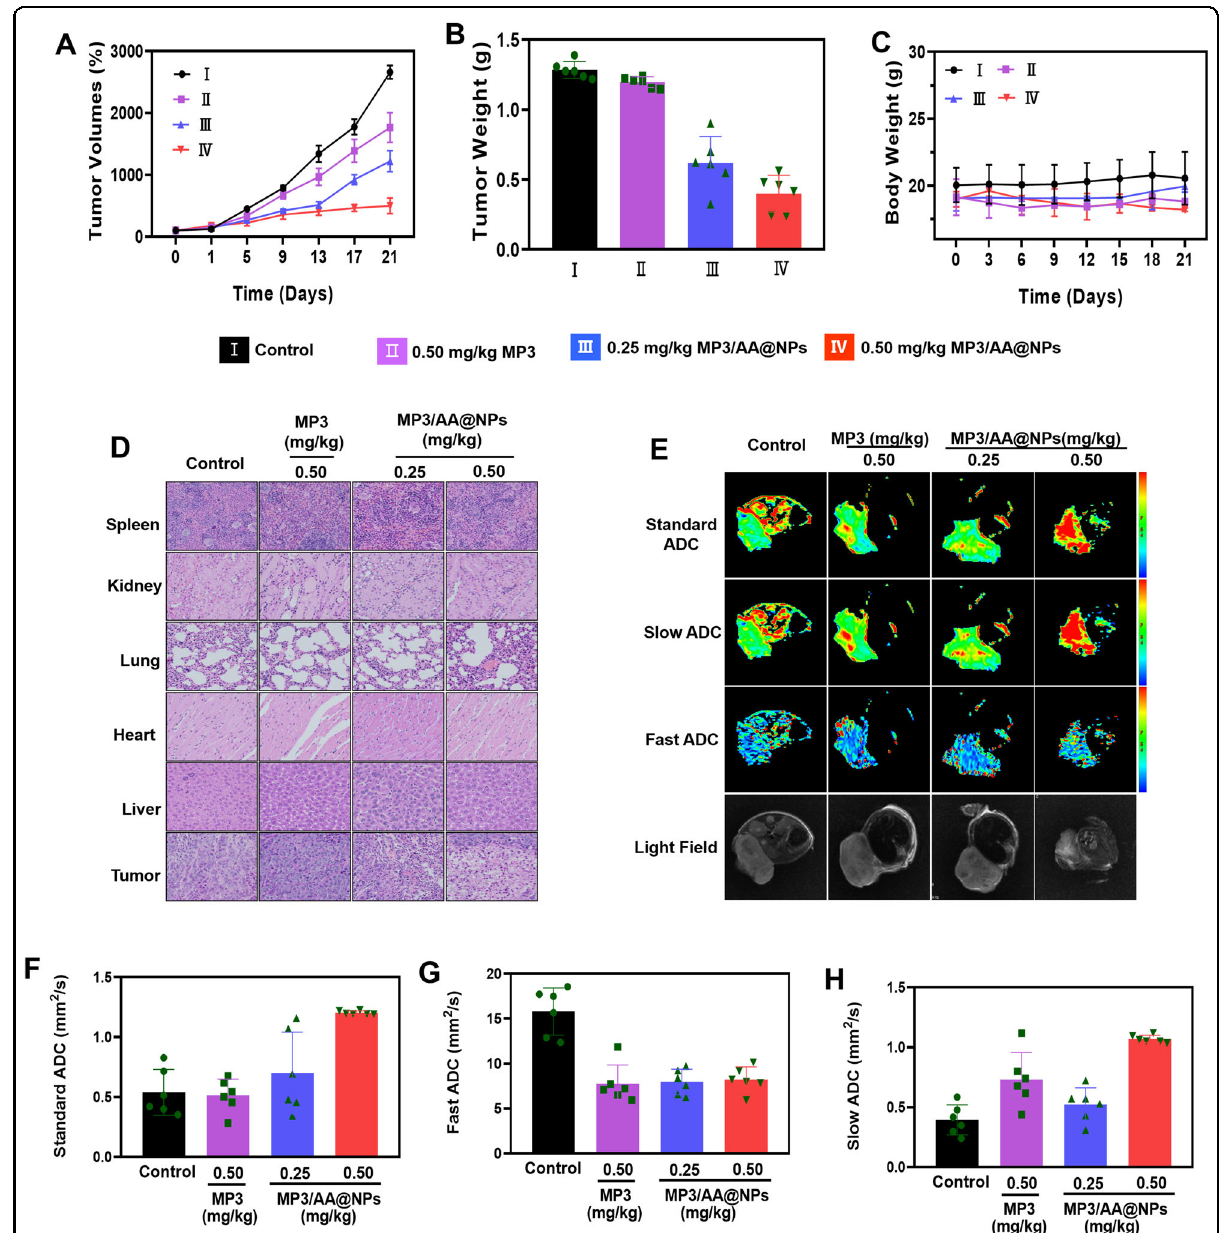
Fig. 6 In vivo therapeutic effects of MP3 and MP3/AA@NPs in MDA-MB-231-bearing mice. A Tumor volumes, B tumor weights, C body weights change. D Histopathology images of major organs and tumor of different treatments groups at 21 days, as determined by H&E staining. E Magnetic resonance imaging of tumor tissues after 21 days of treatment. Quanti fi cation the signals of F standard ADC, G slow ADC, and H fast